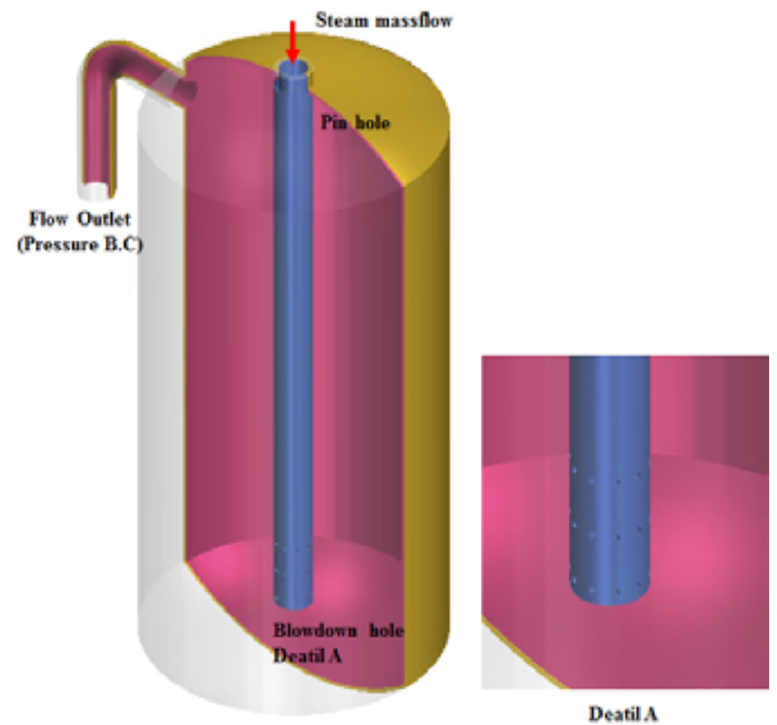
Figure 6. Suppression pool geometrical model [72].